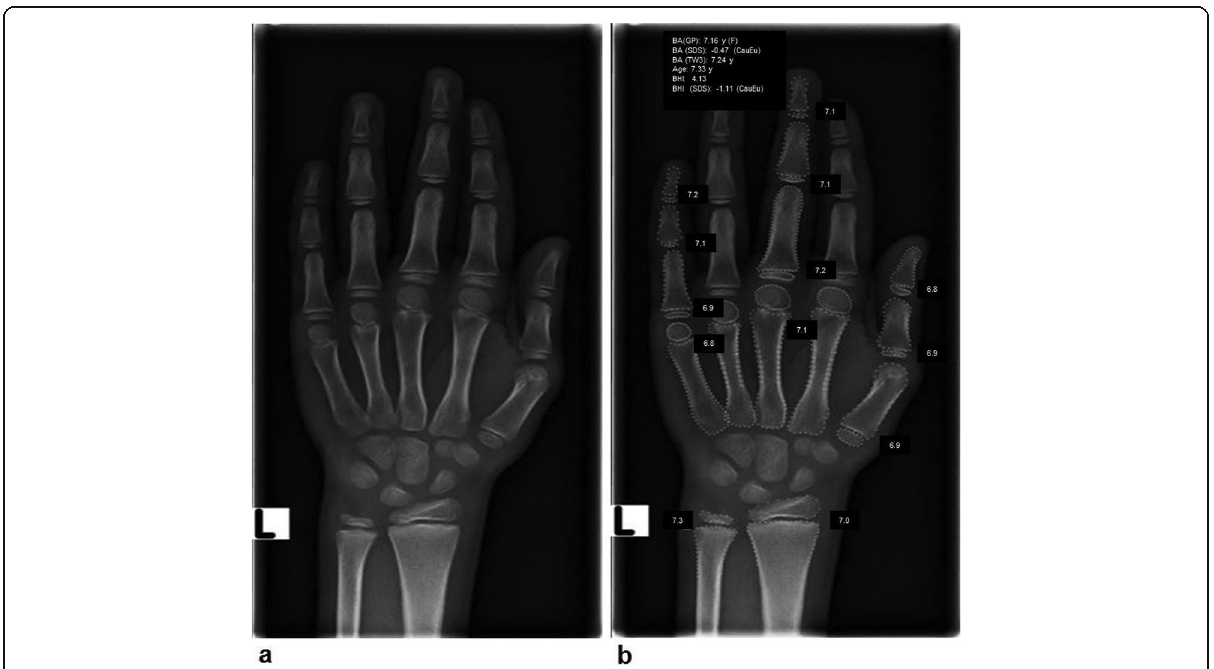
Fig. 1 Radiograph of the left hand and wrist before ( a ) and after ( b ) automated bone age (BA) assessment by the software BoneXpert version 2.1. Bone borders of the analysed bones are automatically marked by the software. The software first calculates the intrinsic overall BA and the BA of each bone. Afterwards, these intrinsic values are transformed into Greulich-Pyle and Tanner-Whitehouse values (version TW3). The values are displayed in the annotated DICOM (Digital Imaging and Communications in Medicine) image as transformed Greulich-Pyle bone age values (BA [GP]) and Tanner-Whitehouse values (BA [TW3]) with respect to sex (F, female). Furthermore, the bone health index (BHI) is also shown with corresponding values. In addition, the standard deviation score (SDS, also known as z -score) is displayed concerning the corresponding population (CauEu, Caucasian European). BA (GP) Greulich-Pyle bone age, BA (SDS) Bone age standard-deviation score, BA (TW3) Tanner- Whitehouse bone age, BHI Bone health index, BHI (SDS) Bone health index standard-deviation score, CauEu Caucasian European, F